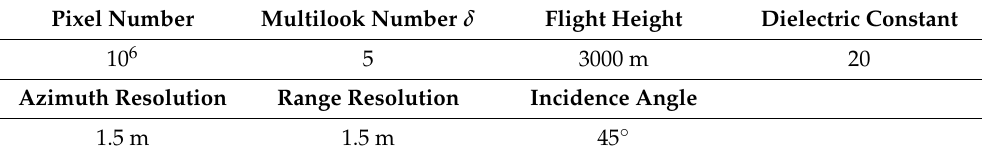
Table 3. The geometry of the acquisition system and polarization properties of ground